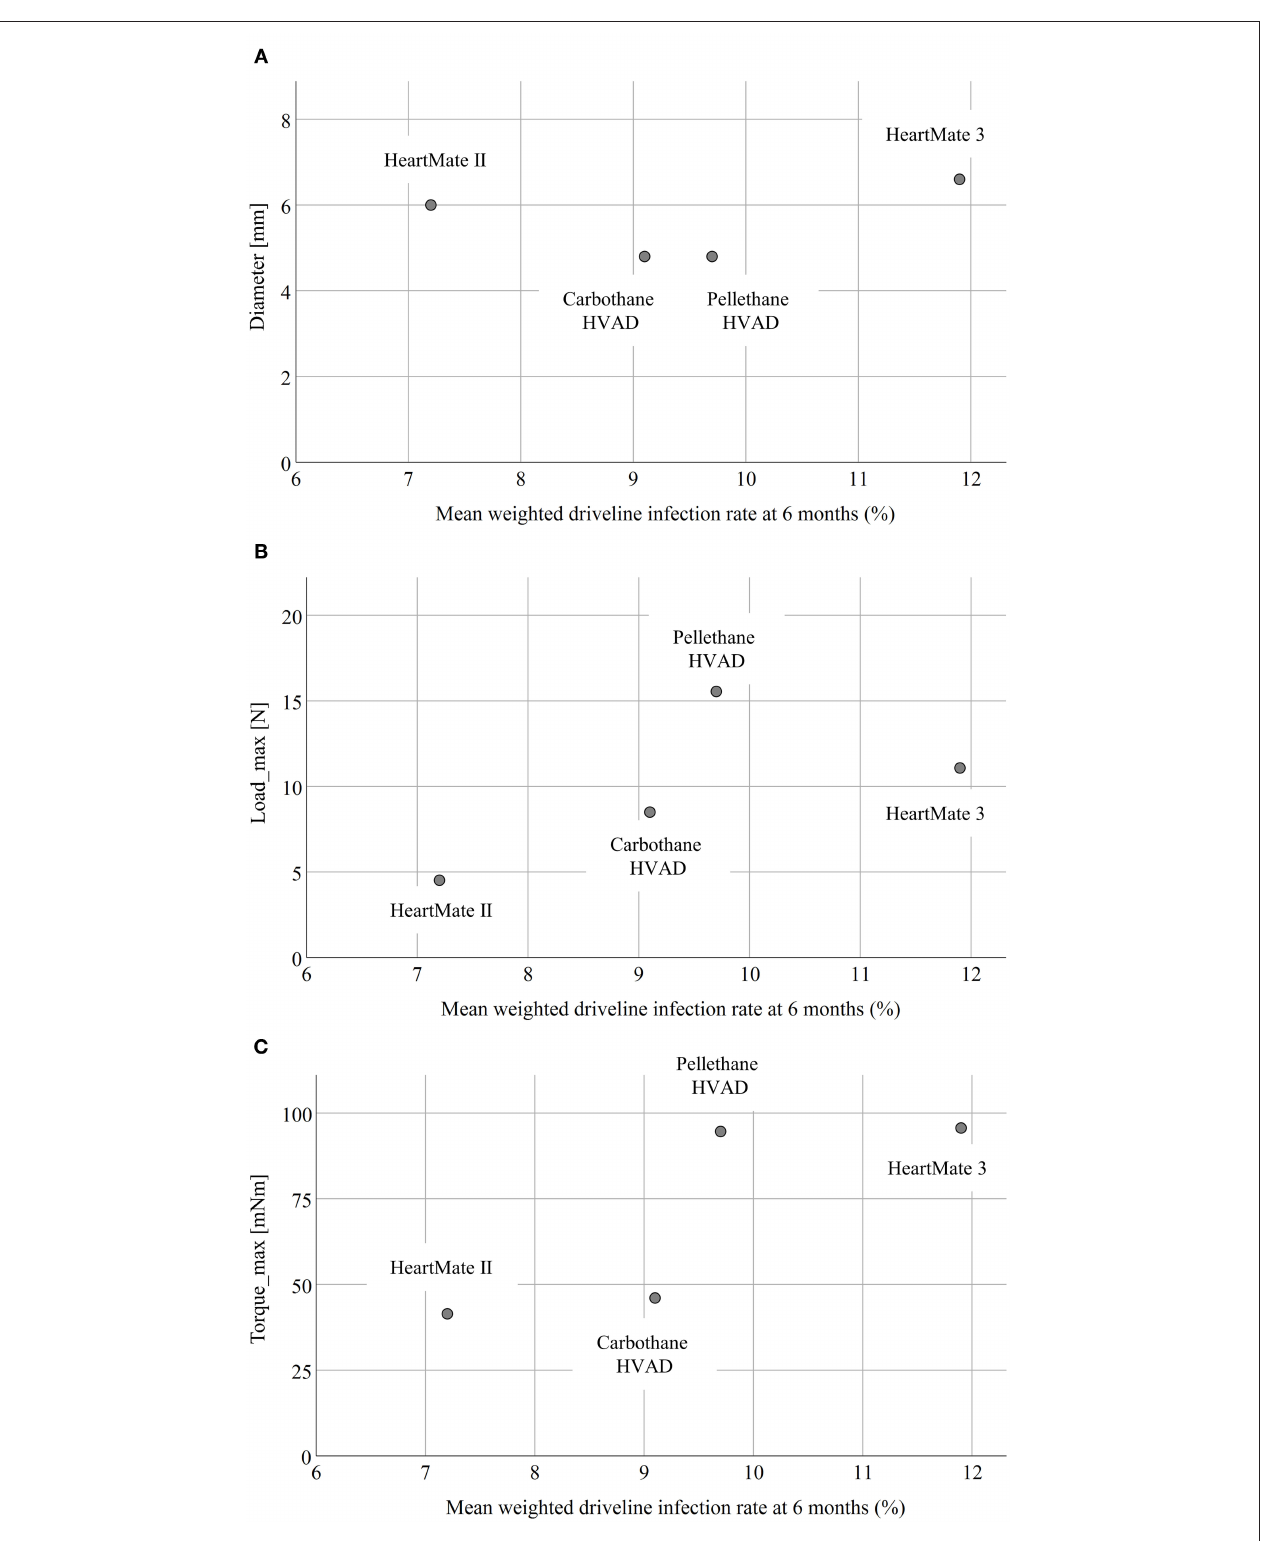
FIGURE 5 | Correlation between the diameter (A) , Load max (B) , and Torque max (C) and the mean weighted driveline infection rate at six months. Load max , maximal bending force; Torque max , maximal